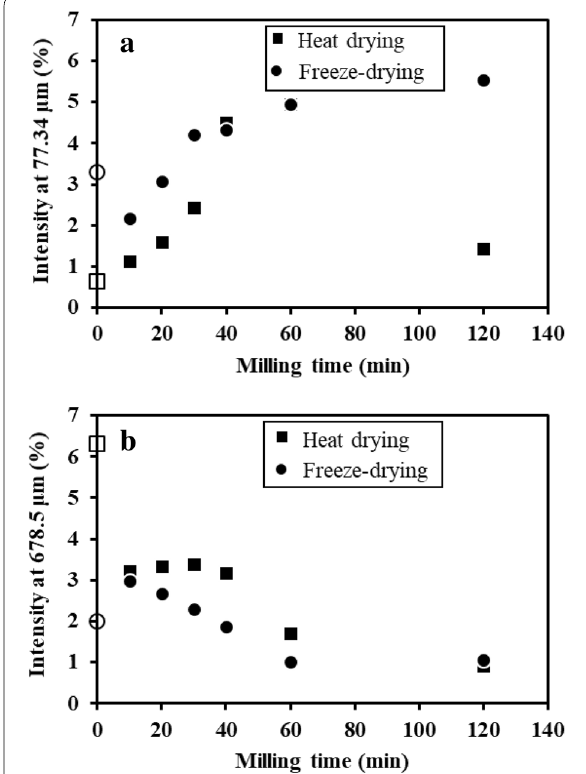
Fig. 6 The relationship between wet milling time and intensity of the particle size distribution analysis at a 77.3 µm and b 678.5 µm.